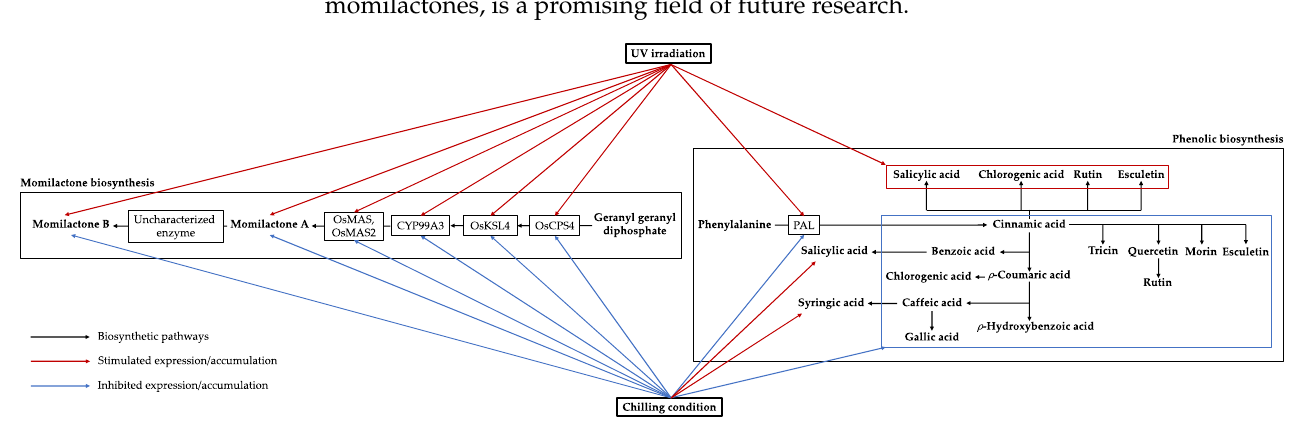
Figure 2. The effects of UV and chilling stresses on the accumulation of rice phenolics and momilactones and the expression of relevant biosynthetic genes. The biosynthetic pathways are aggregated following the schemes described by Anh et al. [23] and Shimura et al. [24]. PAL , gene encoding phenylalanine ammonia-lyase; OsCPS4 , gene encoding syn-copalyl diphosphate synthase-like; OsKSL4 , gene encoding syn-pimara-7,15-diene synthase-like; CYP99A3 , gene encoding 9-beta-pimara-7,15-diene oxidase-like; OsMAS , gene encoding momilactone A synthase-like; OsMAS2 , gene encoding momilactone A synthase-like.